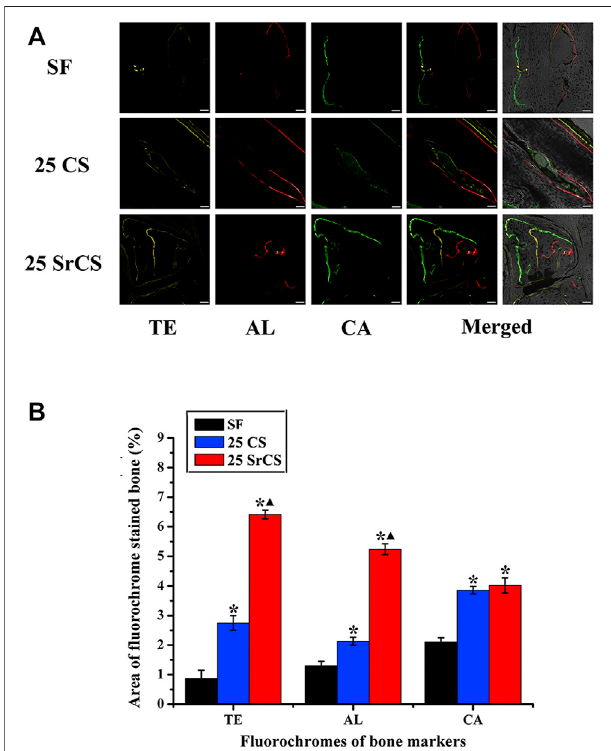
FIGURE 10 | Sequential fl uorescent labeling of TE, AL, and CA. (A) The imagesin yellow (TE), red (AL), and green (CA) indicate bone regeneration and mineralization at 2, 4, and 6 weeks after the operation. Merged images of the three fl uorochromes or with a bright fi eld confocal laser microscopy image for the same group. (B) Percentages of TE, AL, and CA staining by histomorphometric analysis. * p < 0.05 indicates the other groups vs. the SF group,and ▲ p < 0.05indicatesthe25SrCSgroupvs.theothergroups.Scale bar = 100 μ